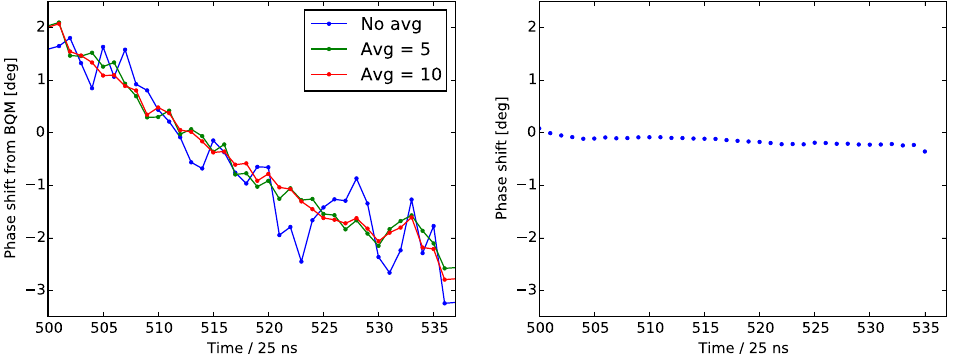
19. Bunch-by-bunch phase shift computed from bunch positions measured by the BQM (left) and measured by the phase module (right). The larger phase shifts in panel (a) are due to beam loading with the one-turn feedback off. Beam 2. Fill 2248 (25 ns, loading effect with the required accuracy is very compli- cated and therefore it is difficult to extract the phase shift due to e-cloud from the measured bunch positions.